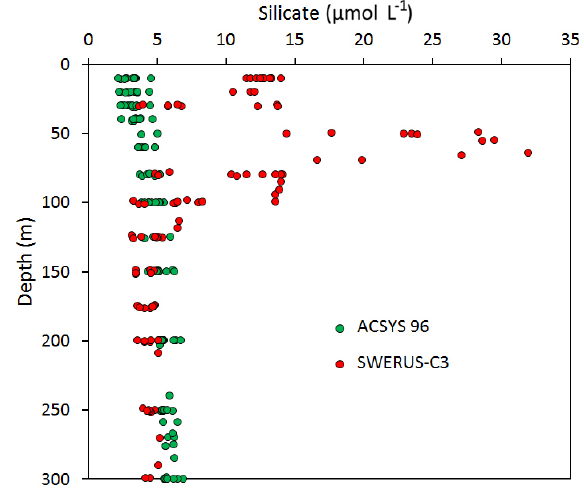
Figure 11. Silicate versus depth for data collected in 1996 (green) and from section B in 2014 (red). The positions of the stations in 1996 are shown by orange points in Fig. 1b.